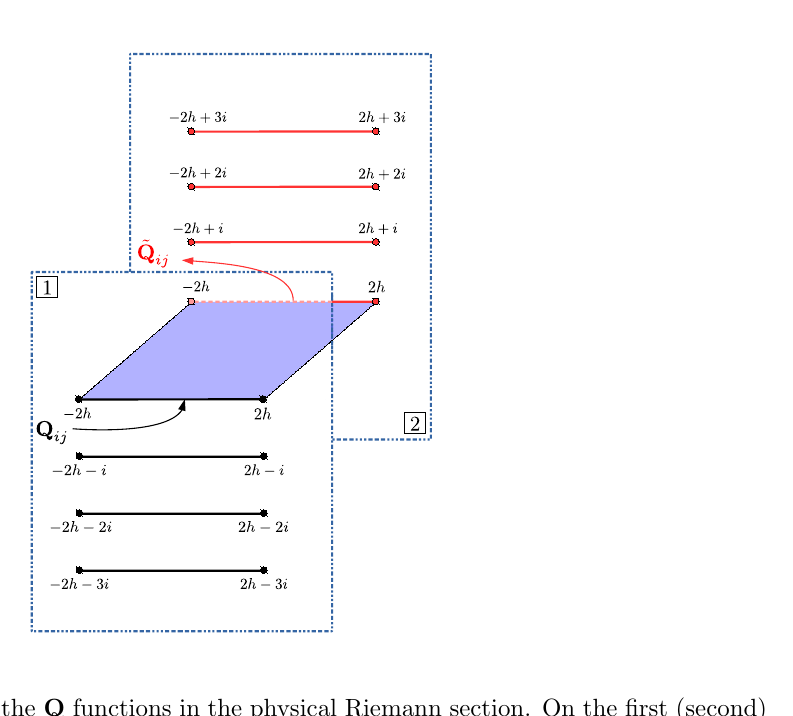
Figure 3 . Cut structure of the Q functions in the physical Riemann section. On the (cid:12)rst (second) sheet, Q is analytic in the upper (lower) half